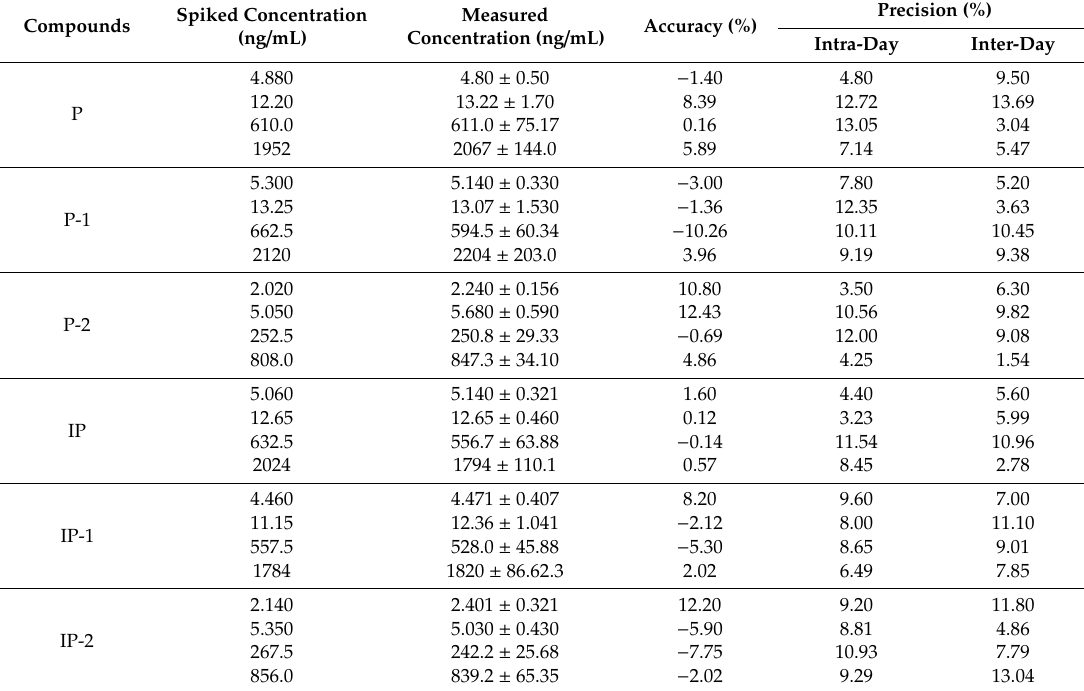
Table 3. Precision and accuracy of the determination of six compounds in the human intestinal flora ( n = 18, six replicates per day for three days). Spiked Concentration Measured Compounds Accuracy (ng / mL) Concentration (ng / mL)